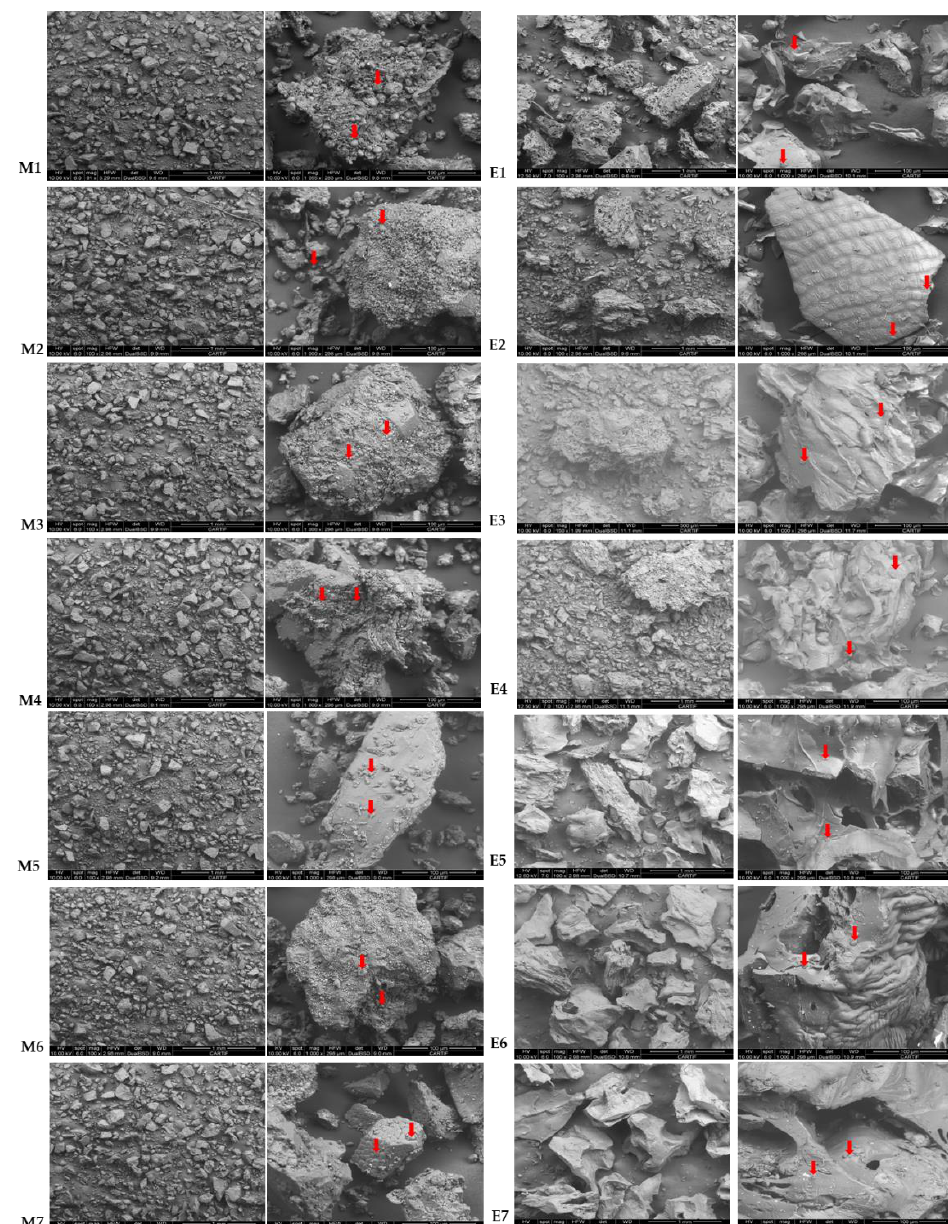
Figure 3. Scanning electron microscope (SEM) images of Native (M1-M7) and extruded (E1-E7) rice and blend flours. Arrows indicate starch granules. (M1-M7). M1/E1(100RF), M2/E2 (12.5WTF/12.5 BTF/75RF), M3/E3 (25WTF/75RF), M4/E4 (25BTF/75RF), M5/E5 (25WTF/25 BTF/50RF), M6/E6 (50WTF/50RF), M7/E7 (50BTF/50RF).